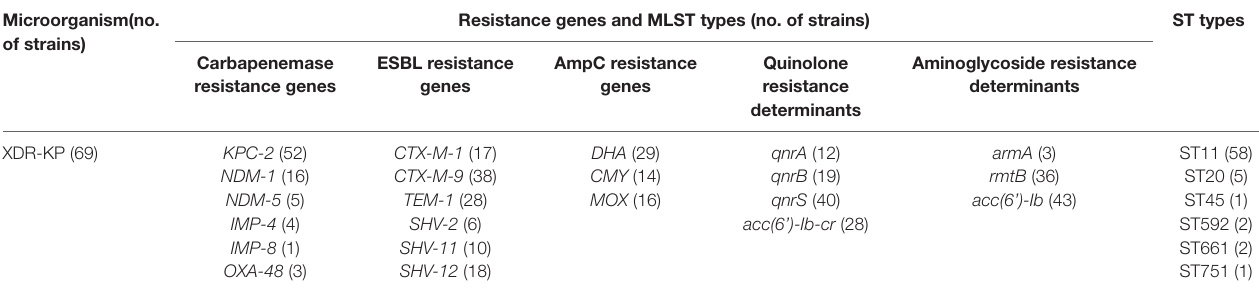
TABlE 2 | Distribution of resistance genes and MLST types of extensively drug-resistant Klebsiella pneumoniae (XDR-KP). Microorganism(no. of